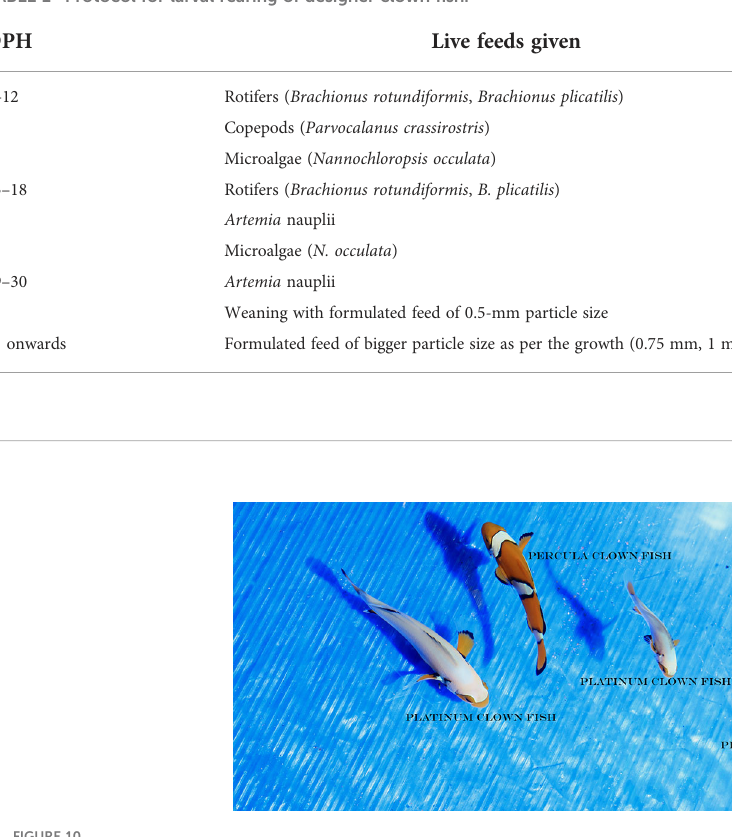
TABLE 1 Protocol for larval rearing of designer clown fi sh.